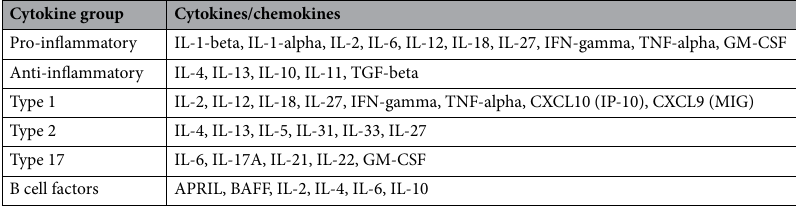
Table 2. Grouping of cytokines and chemokines based on the type of immune